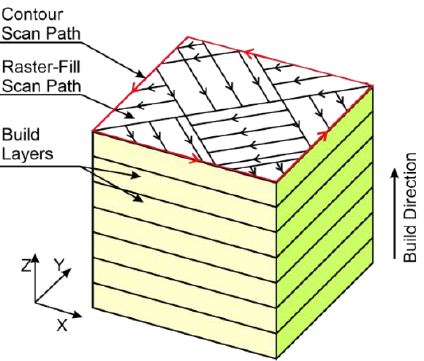
Figure 2. Schematic representation of the laser scanning strategy.